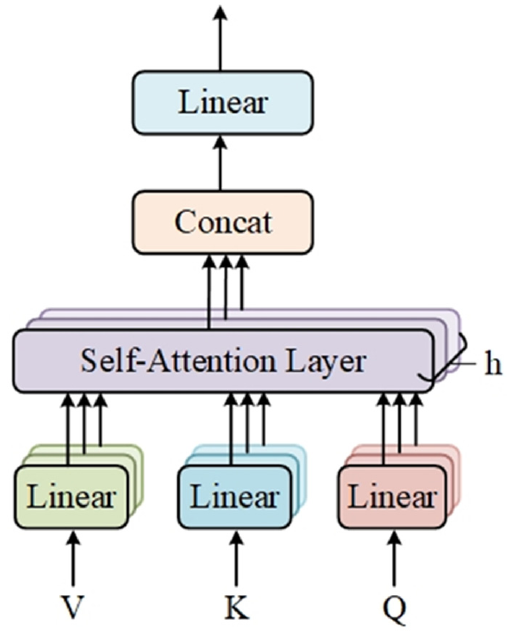
Figure 6. Structure of multi head attention mechanism.